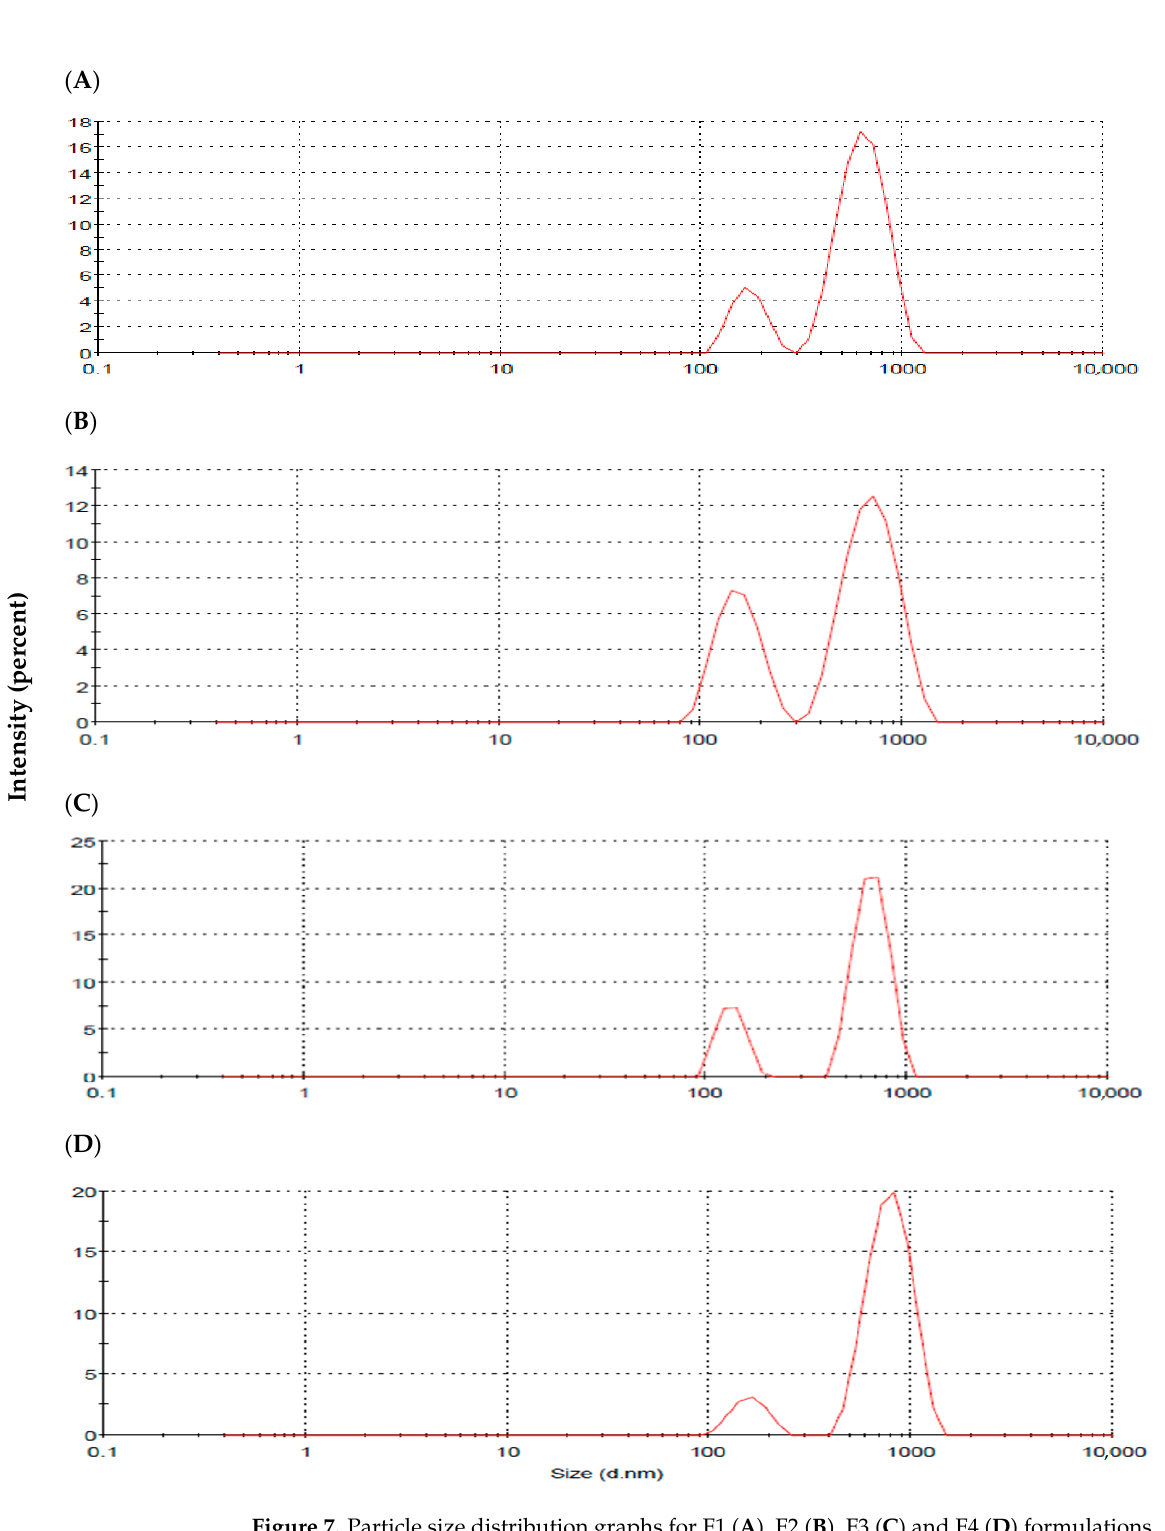
Figure 7. Particle size distribution graphs for F1 ( A ), F2 ( B ), F3 ( C ) and F4 ( D ) formulations.